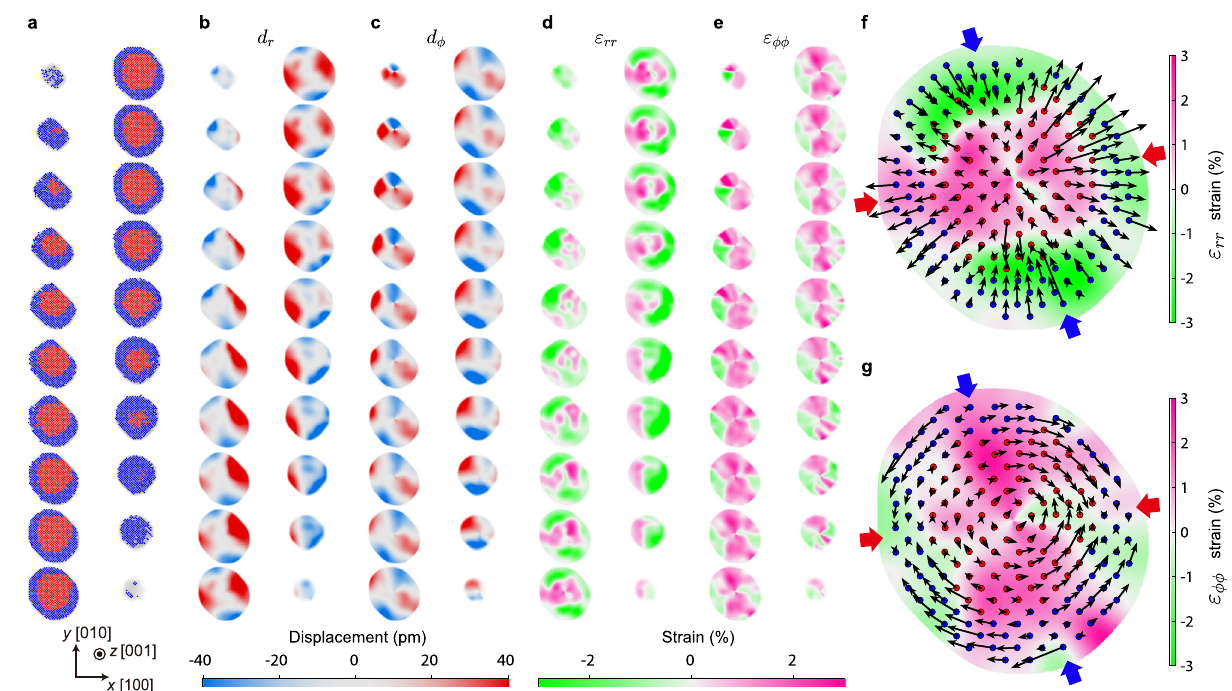
Fig. 2 | 3D atomic displacements and strain maps of the Pd@Pt nanoparticle. a Atomic layers (sliced along the [001] direction) of the core-shell nanoparticle. Note that only one layer per every two atomic layers is plotted. Red and blue dots represent the positions of the Pd and Pt atoms assigned to the fcc lattice, respec- tively, and black dots represent the positions of atoms not assigned to the fcc lattice(Methods). b – c 3Datomicdisplacementmaps,alongtheradialdirection( d r ) ( b ), and along the azimuthal direction ( d ϕ ) ( c ) in the spherical coordinate system. d – e 3D strain maps in spherical coordinates, representing radial ( ε rr ) ( d ) and azi- muthal ( ε ϕϕ ) ( e ) strains, respectively (Methods). The atomic displacement and